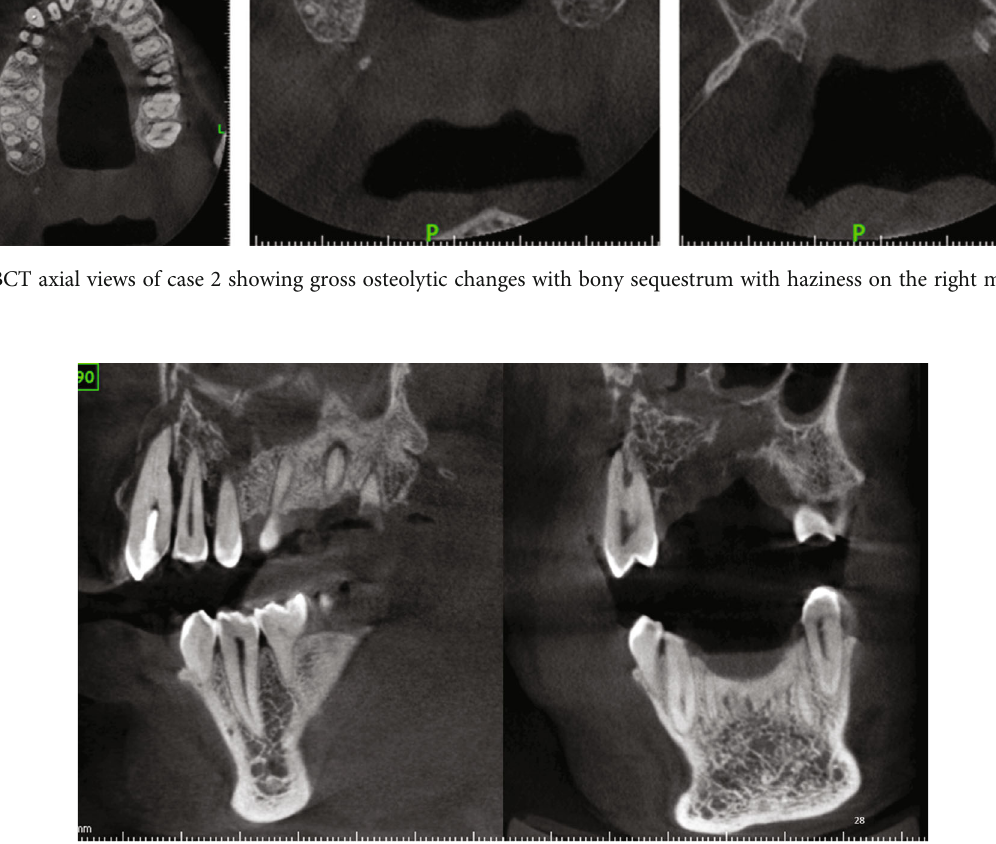
Figure 8: CBCT sagittal and coronal views of case 2 showing bony sequestrum with gross osteolytic changes in fi ltrating the fl oor of the maxillary